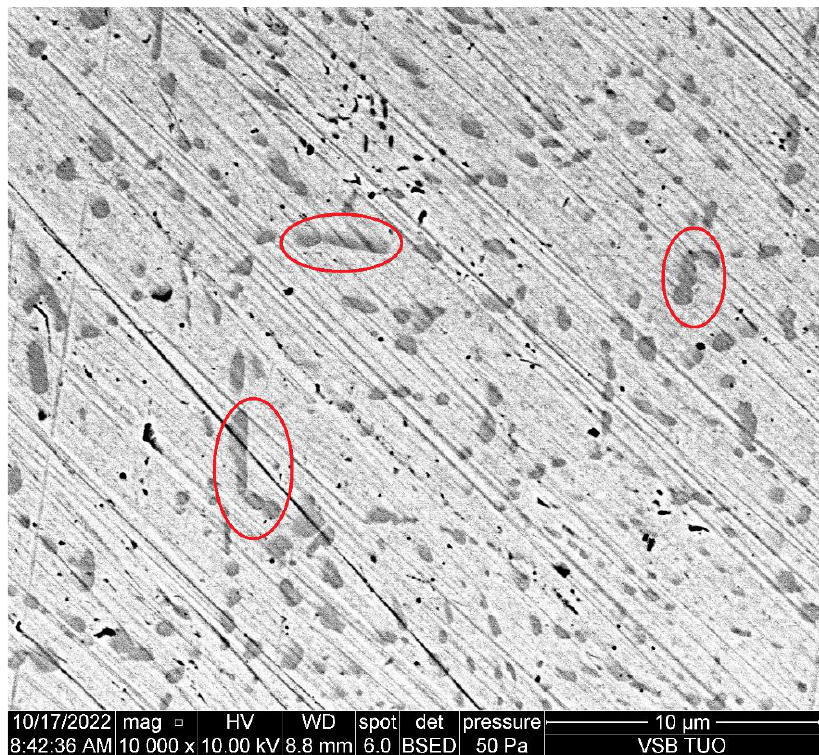
Figure 6. Carbides in the steel 1.4034 (picture from the SEM microscope). Red circles show the largest carbides in the picture.